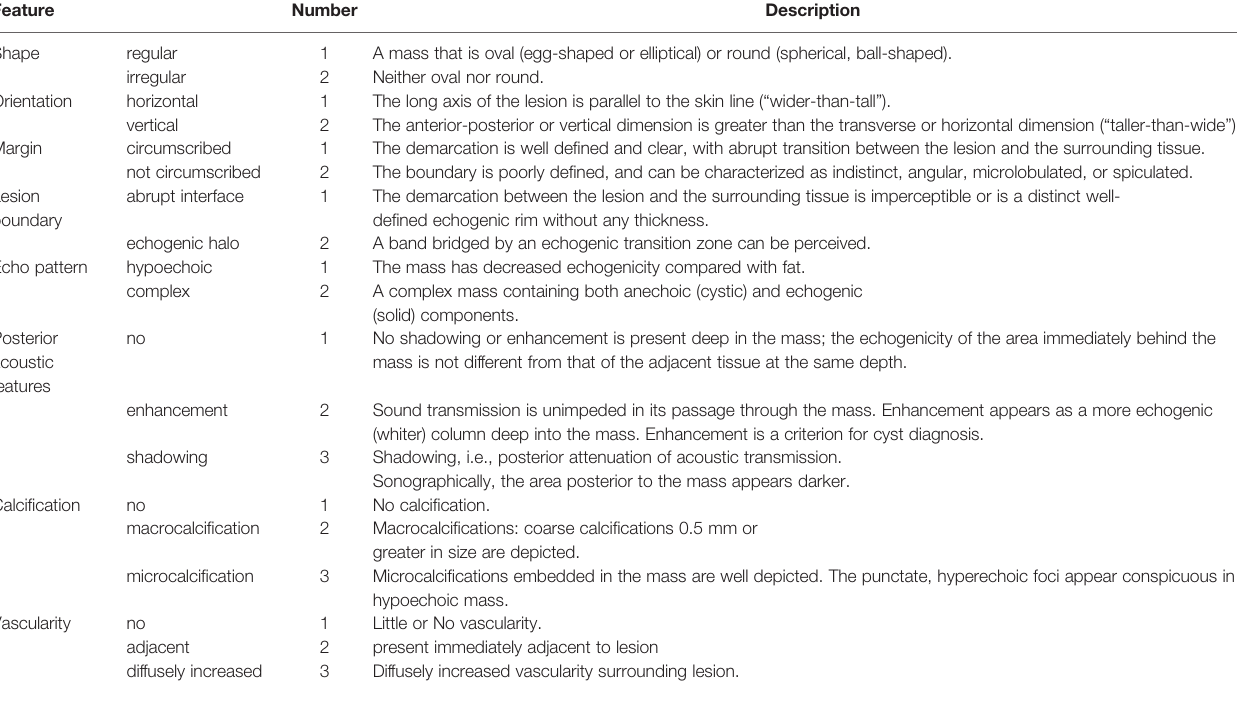
TABLE 1 | Extracted US